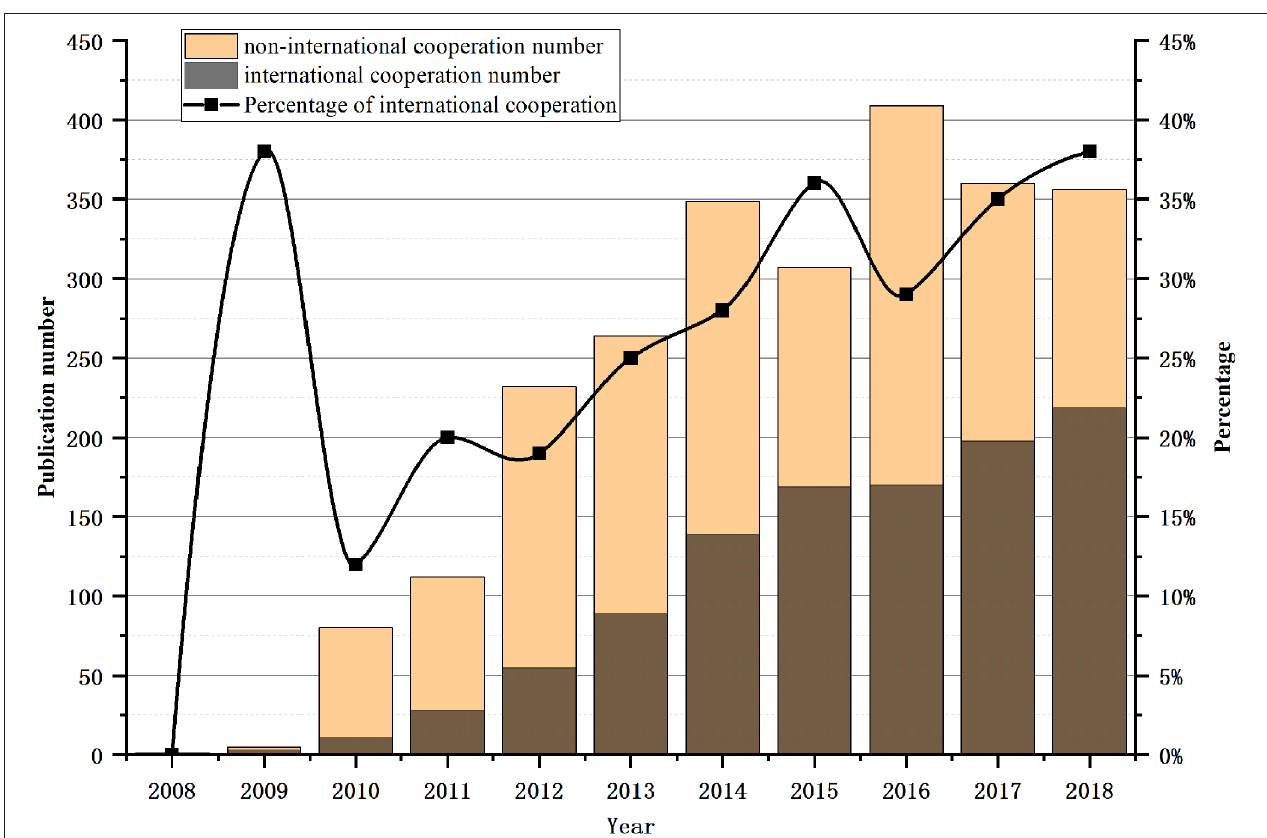
FIGURE 3 | Annual literature distribution of international and non-international